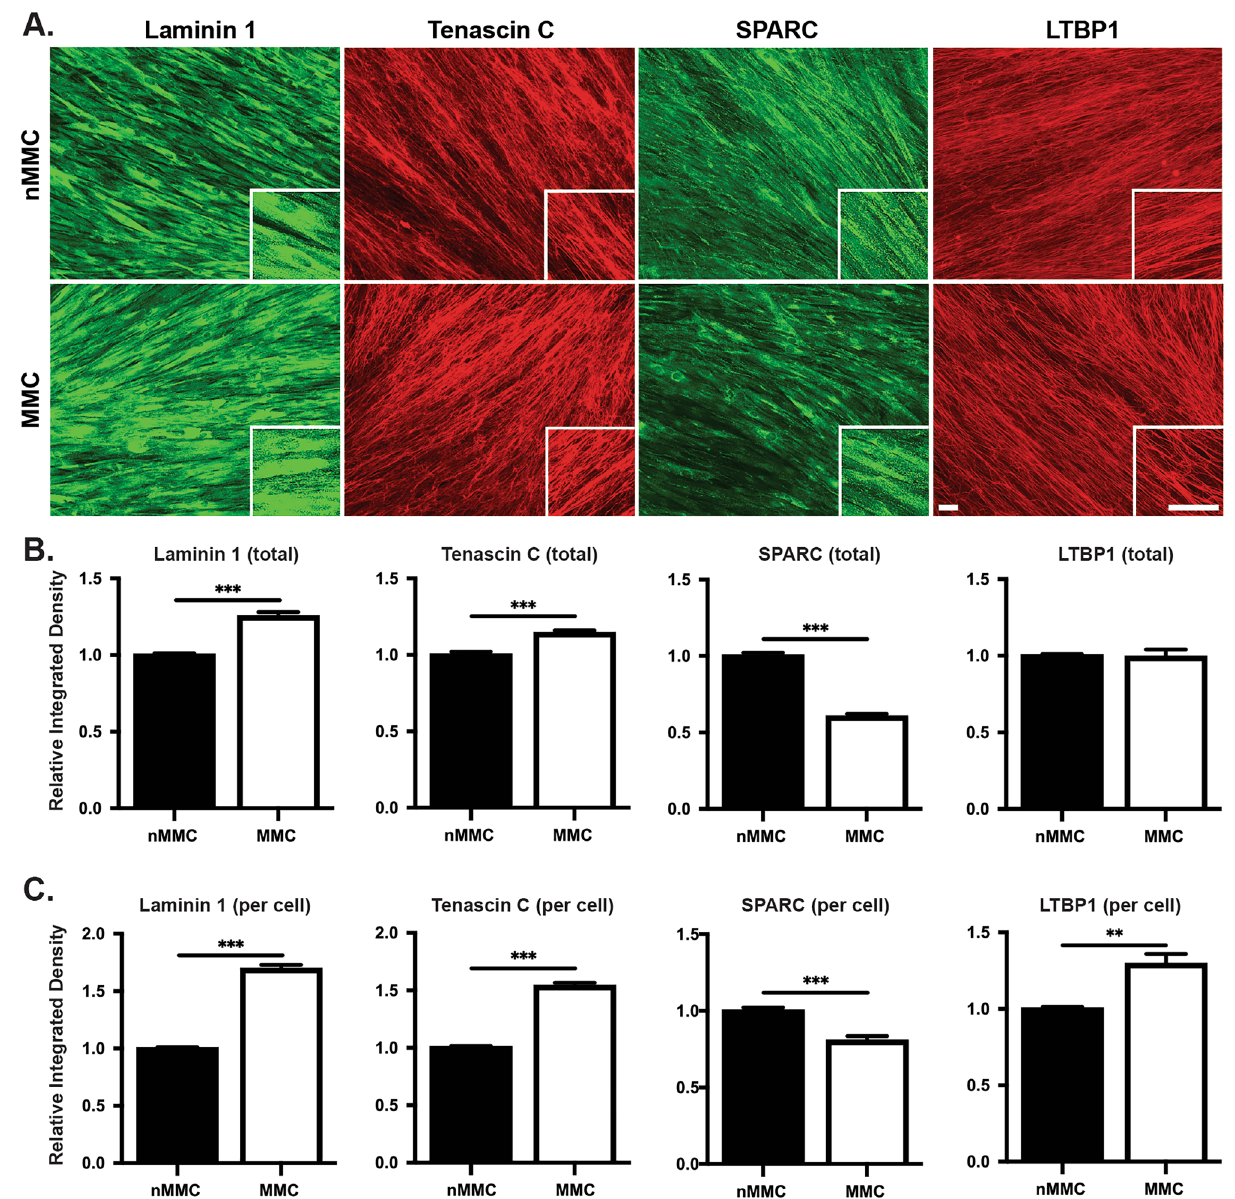
Results show mean + /− SEM from image analysis performed with 6–12 images obtained from each time point and treatment from two repeated experiments ( B , C ). Statistical testing was performed by independent samples t-test, **p < 0.01; ***p <